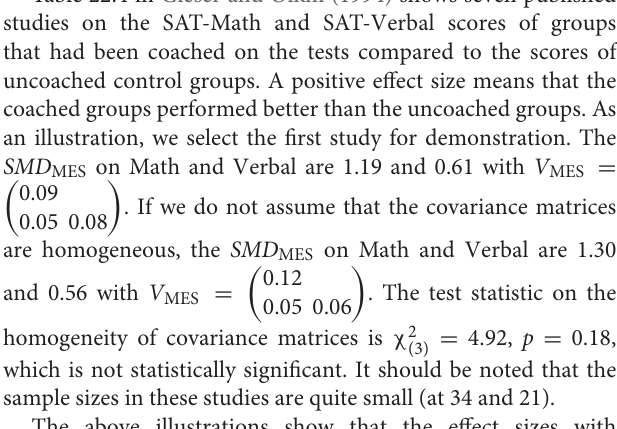
Table 22.4 in Gleser and Olkin (1994) shows seven published studies on the SAT-Math and SAT-Verbal scores of groups that had been coached on the tests compared to the scores of uncoached control groups. A positive effect size means that the coached groups performed better than the uncoached groups. As an illustration, we select the first study for demonstration. The